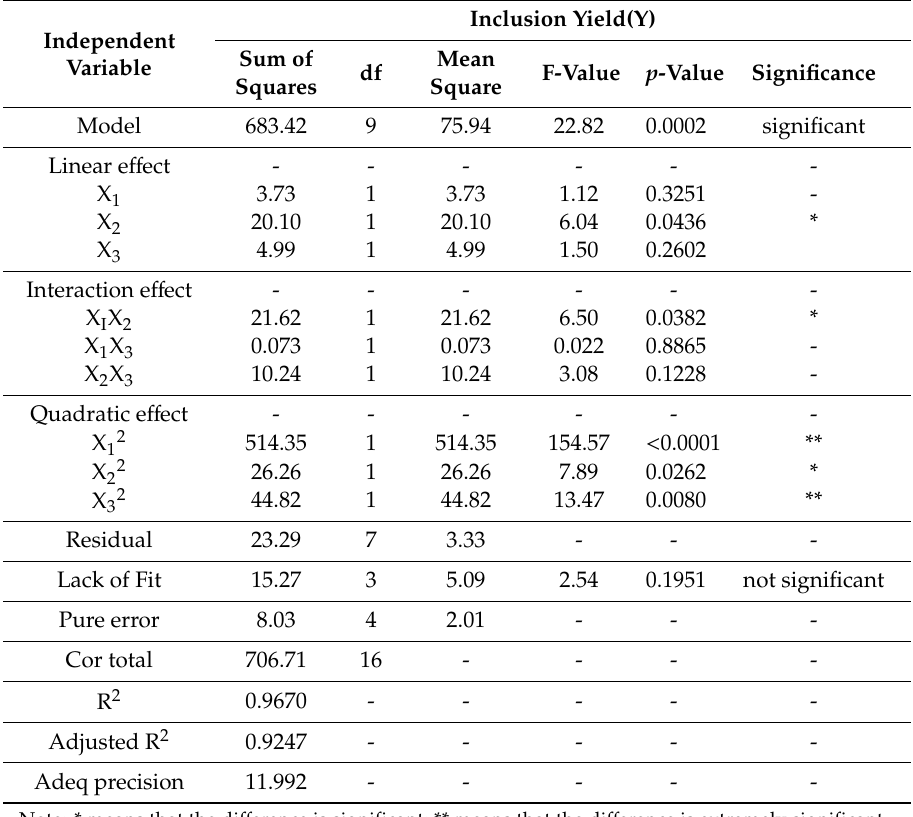
Table 3. Analysis of variance (ANOVA) of the regression coe ffi cients of the fitted quadratic equations for inclusion yield